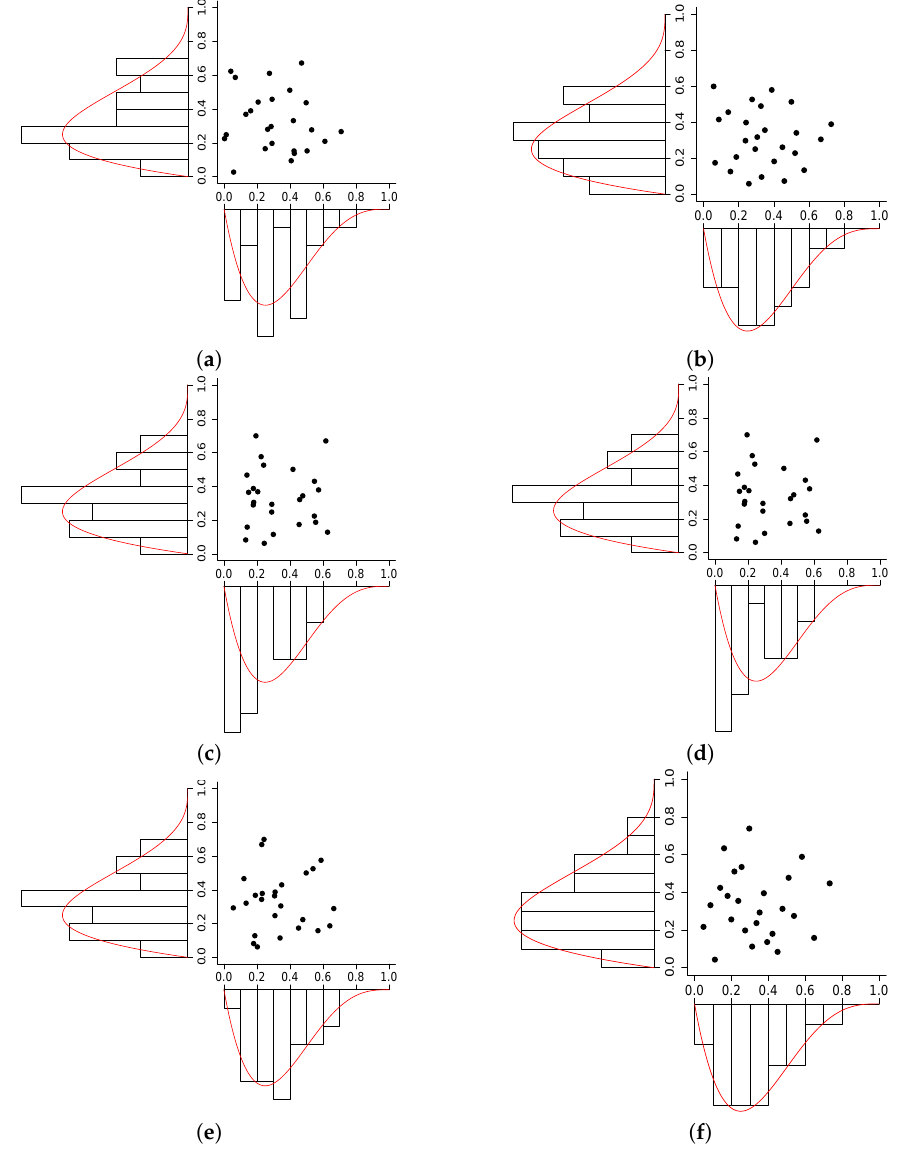
Figure 3. Scattarplots and marginal histograms of n = 25 points for 5-dimensional i.i.d Beta(2,4) with six samplers. Red lines represent the true marginal densities. ( a ) MC; ( b ) RQMC; ( c ) SP; ( d ) PSPs; ( e ) PSPl; ( f )